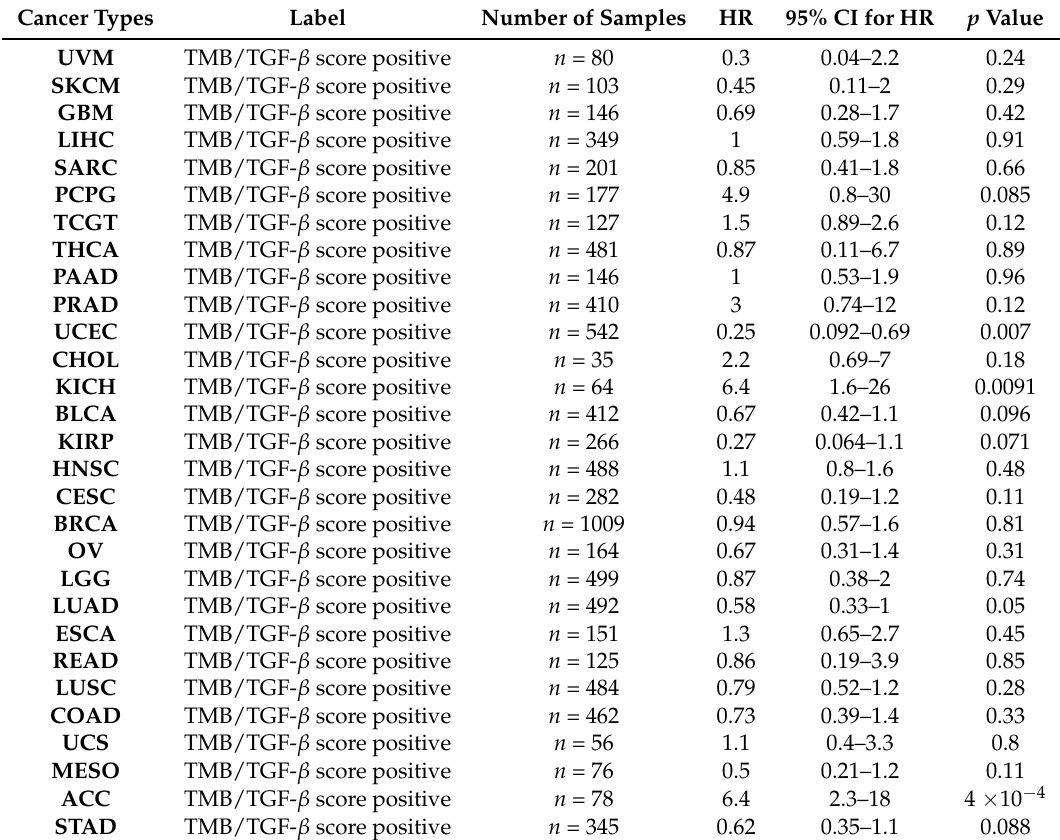
Table A1. Univariate Cox proportional hazards model analysis of survival for each cancer type included in the study.